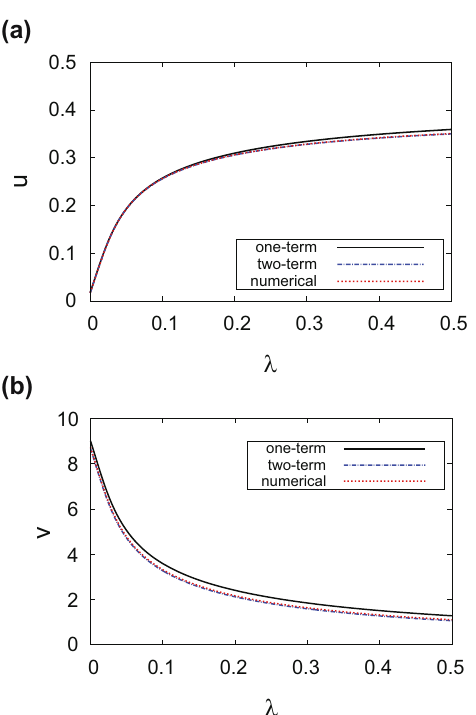
Figure 2: The unique pattern of steady state bifurcation diagrams for ( a ) autocatalyst u and ( b ) reactant v concentrations, respectively, against the bifurcation parameter λ , at x 0 = . All parameter values were fi xed at